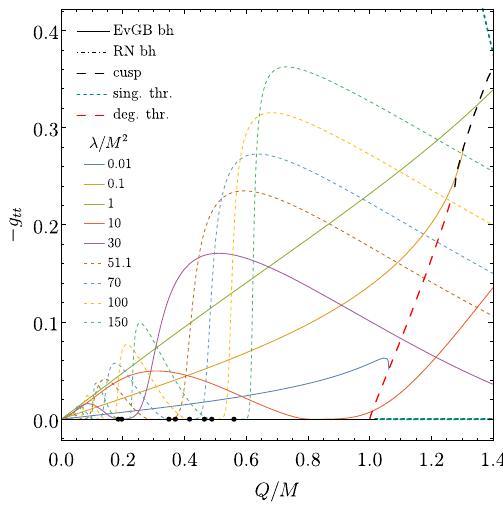
Fig. 16 Zoom of Fig.